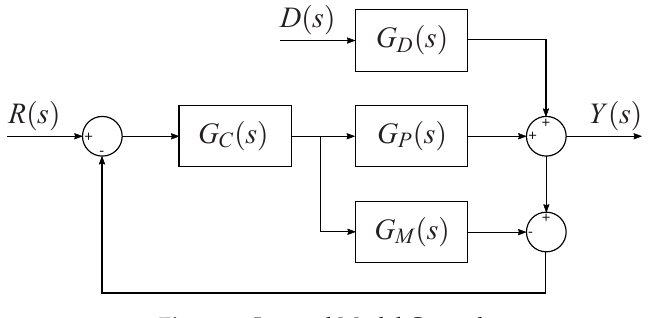
Figure 1. Internal Model